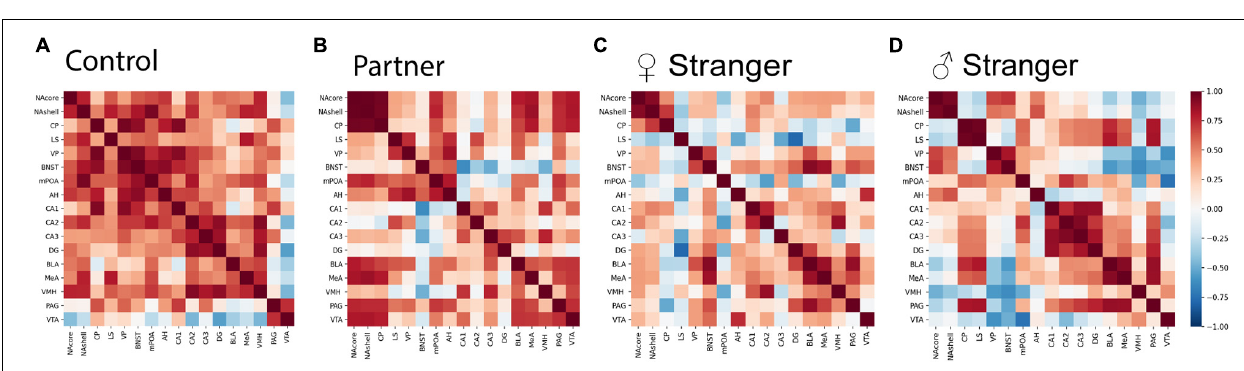
FIGURE 4 | Interregional Pearson correlation heat maps for each social exposure. (A) Correlation heat map for control, (B) partner exposure, (C) opposite-sex stranger, and (D) same sex stranger (control, n = 7; partner, n = 9; opposite-sex stranger, n = 9; same sex stranger, n =